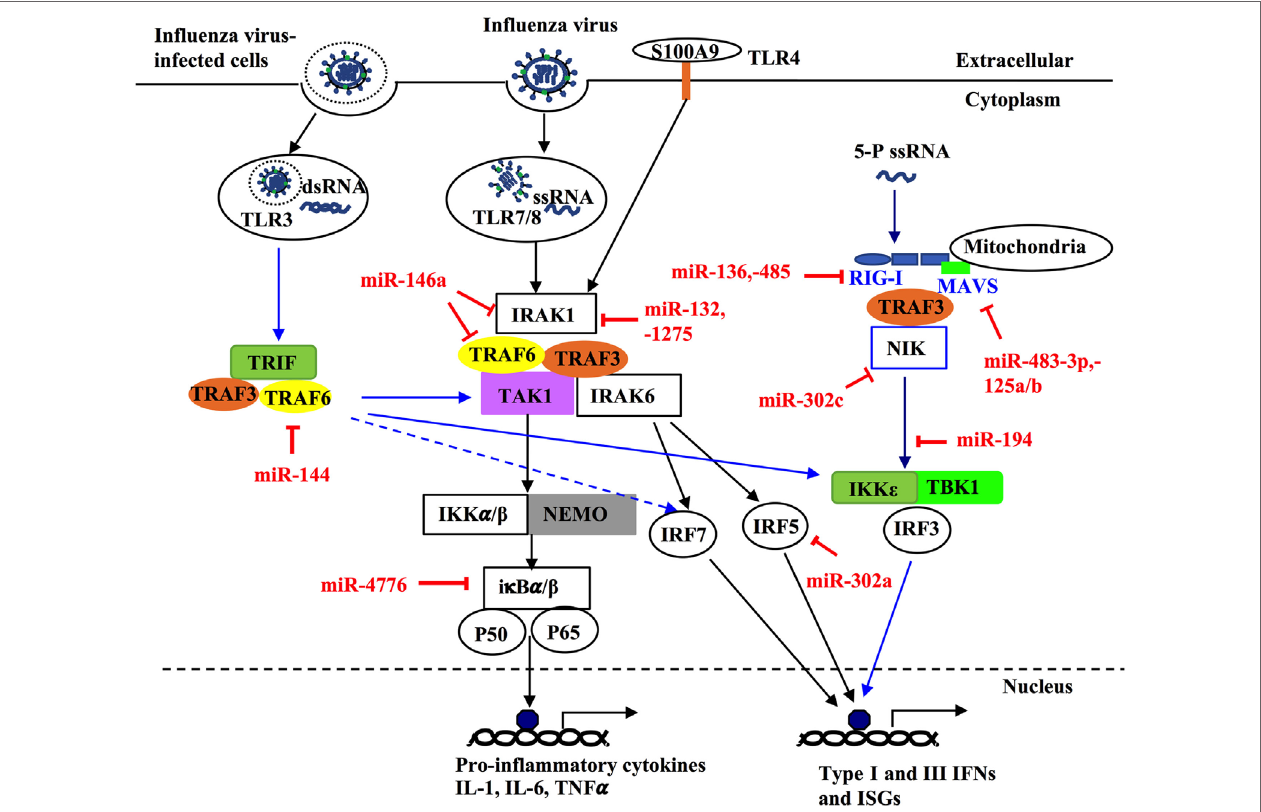
FigURe 3 | MicroRNAs (miRNAs) regulate innate host immune response against influenza infection by targeting intracellular signaling pathways . Upon infection, influenza can activate different intracellular signaling pathways such as NF- κ B, RIG-like receptor (RIG-I), TNF receptor-associated factors (TRAFs), and interferon regulatory factors (IRFs) through different pattern recognition receptors including TLR3, TLR4, TLR7/8. TLR3 and TR7/8 that recognize double stranded RNA and single-stranded RNA in the endosome, respectively. The ligand for TLR4 in influenza virus is unknown; however, it is thought to be activated by the damage-associated molecular patterns molecules released in influenza virus-infected cells and trigger TLR4-MyD88-signaling pathways. Induction of these TLRs can lead to activation of NF- κ B, IRF 3, 5, and 7 and induce expression of type-I and -II IFN, IFN-stimulated genes, and inflammatory genes. Some miRNAs regulate these pathways through targeting critical components such as TRAF6, IRF3, IRF5, IFR7, interleukin-1 receptor-associated kinase 1, and I κ B β . Within the infected cells, RIG-I detects the 5-triphosphorylated RNA of replicating viral genomes in cytosol and associates with mitochondrial antiviral signaling protein (MAVS) to induce pro-inflammatory cytokines and type-I IFN. miRNAs can modulate this pathway by directly targeting RIG-I, MAVS, or NF- κ B-inducing